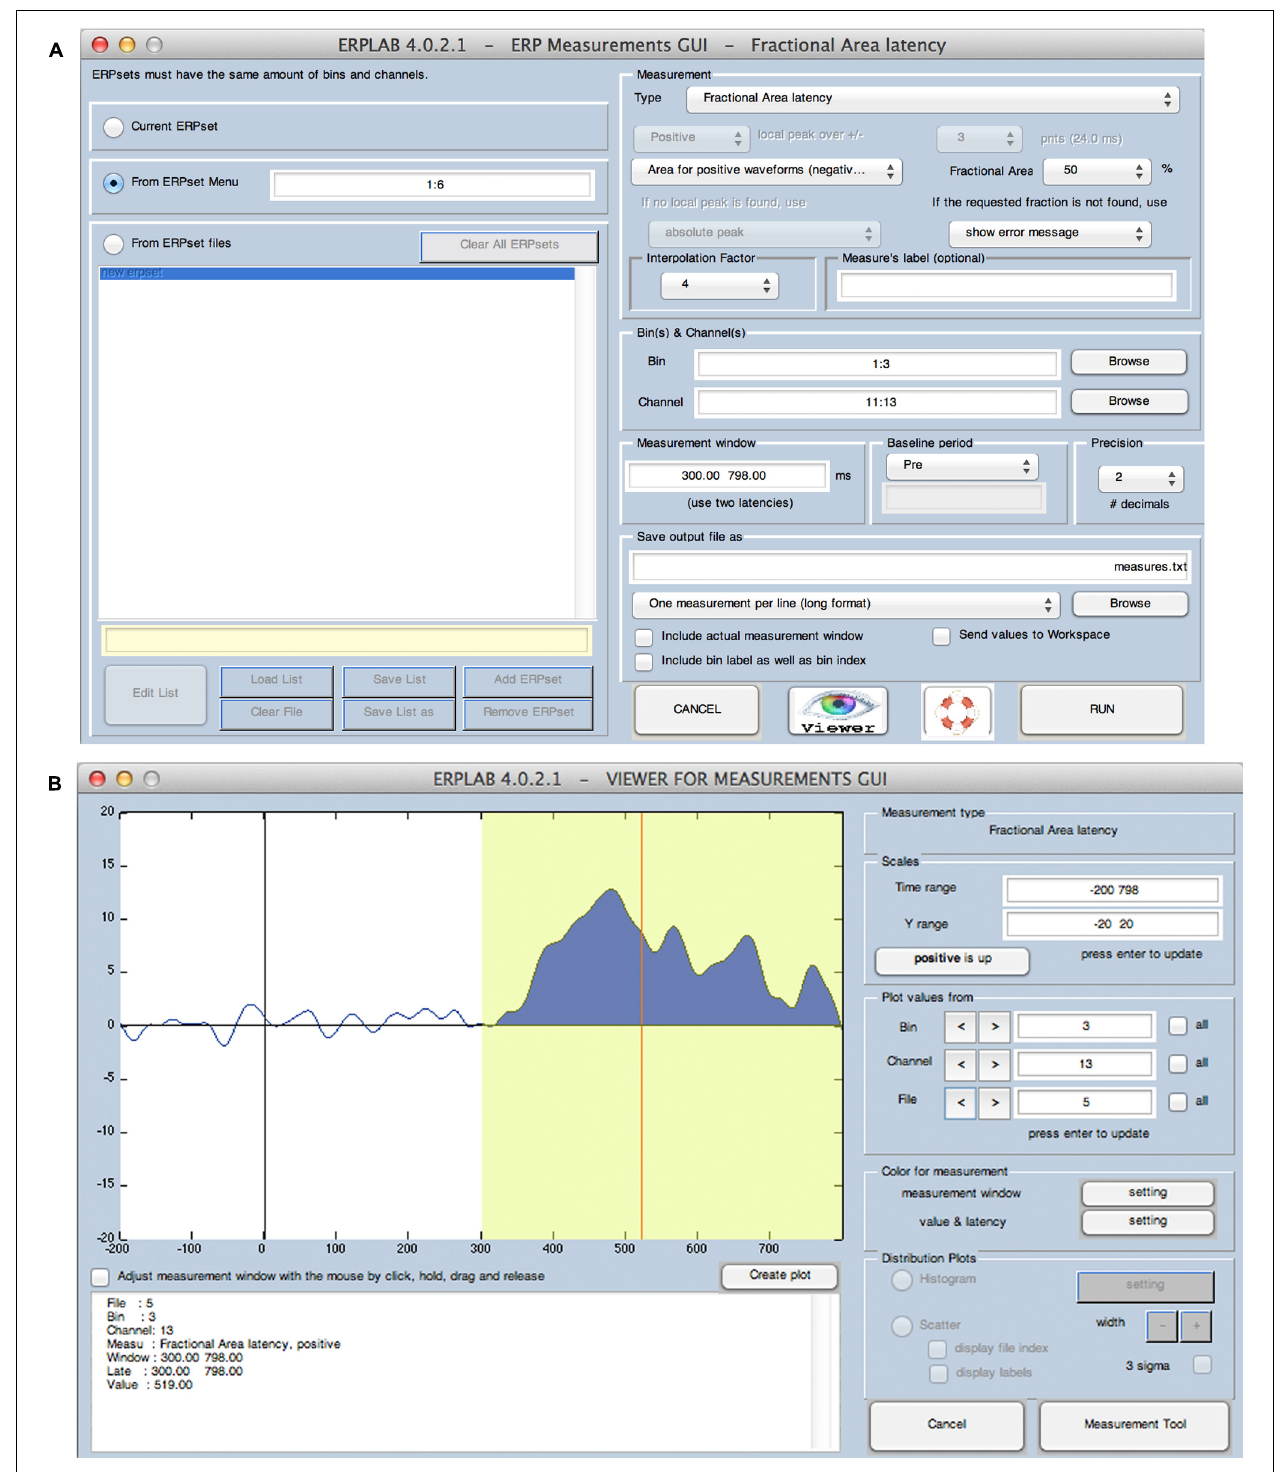
FIGURE 5 | ERPLAB’s interface for controlling the algorithms used for measuring amplitudes and latencies (A) and for viewing the application of these algorithms to individual ERP waveforms (B). In this example, the